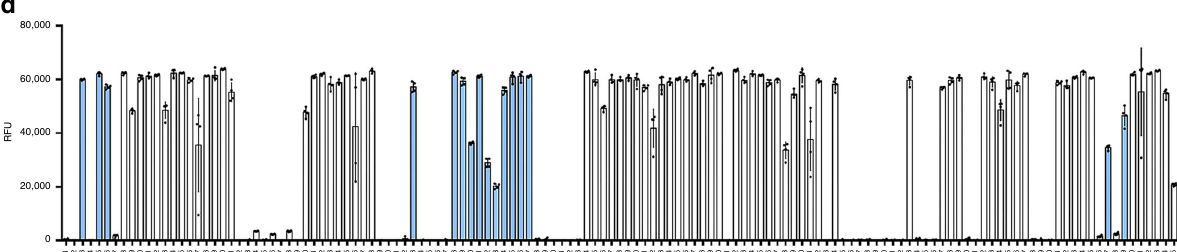
syn - ψ conformation ( − 8.9 versus − 9.5 kcal/mol, estimated by MM calculations for the disaccharide containing A G0 – B G0 units). The sugars forming the branching part of G0 (C G0 , D G0 , E G0 , F G0 and G G0 ) are located in the exosite formed by the loop β 10 – β 11 and the SH3 domain (Fig. 5a). C G0 establishes a CH – π interaction with Tyr498 and provides one hydrogen bond between C G0 OH4 and Asp495 side chain. D G0 is poorly recognized by a lonely hydrogen bond between D G0 OH6 and the Glu373 backbone. However, the terminal GlcNAc moiety in the α 1,3 arm, E G0 , is the most intimately recognized monosaccharide residue of all branched sugars. E G0 established three hydrogen bonds that are formed between E G0 OH6 and His535 side chain,